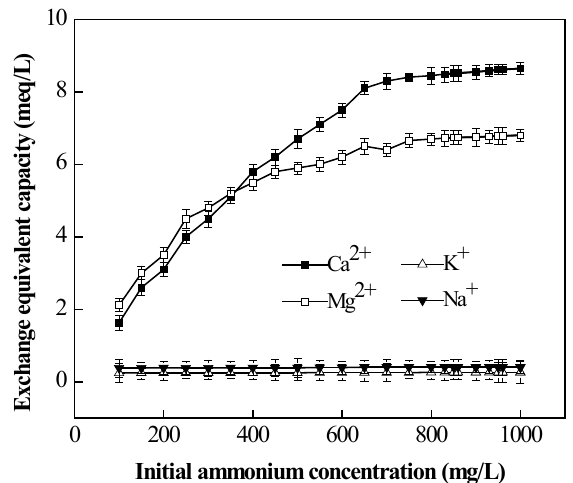
Figure 4: Exchange equivalent capacity of Ca 2+ , Mg 2+ , Na + and K + with initial ammonium concentration in adsorption